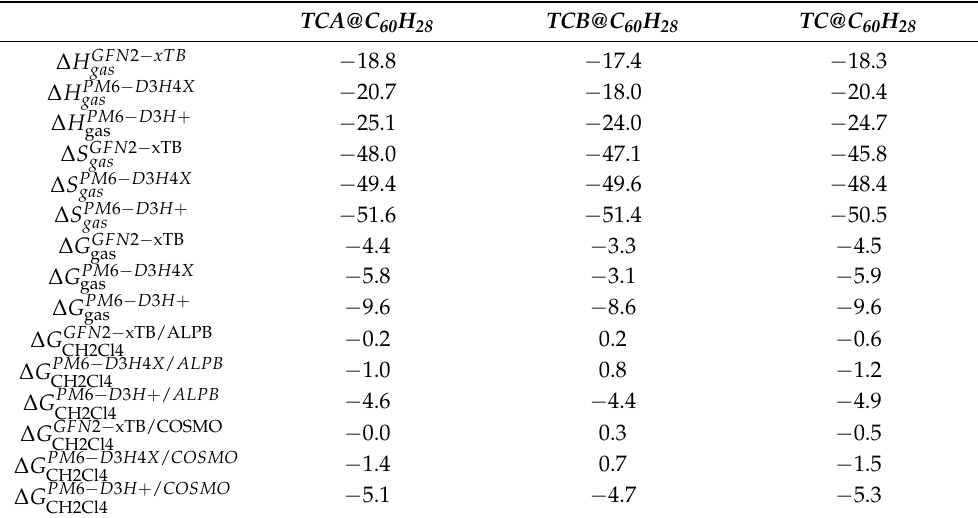
Table 7. Enthalpies (kcal/mol), entropies (cal/[K.mol]) and Gibbs free energies (kcal/mol) for the formation of complexes between the buckycatcher and several solvents at 300 K. Dissociation con- stants (K d ) calculated in solution.